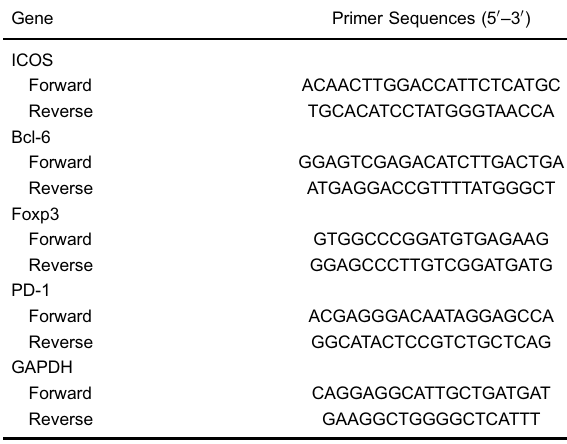
Table 1. Primer sequences used for